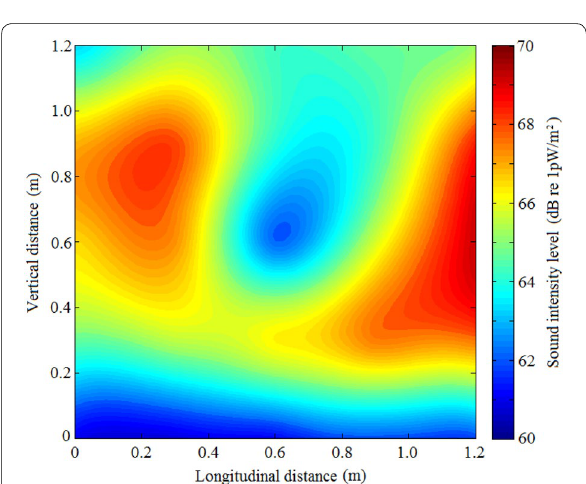
Figure 18 Sound intensity level of the exterior sidewall (100– 5000 Hz)